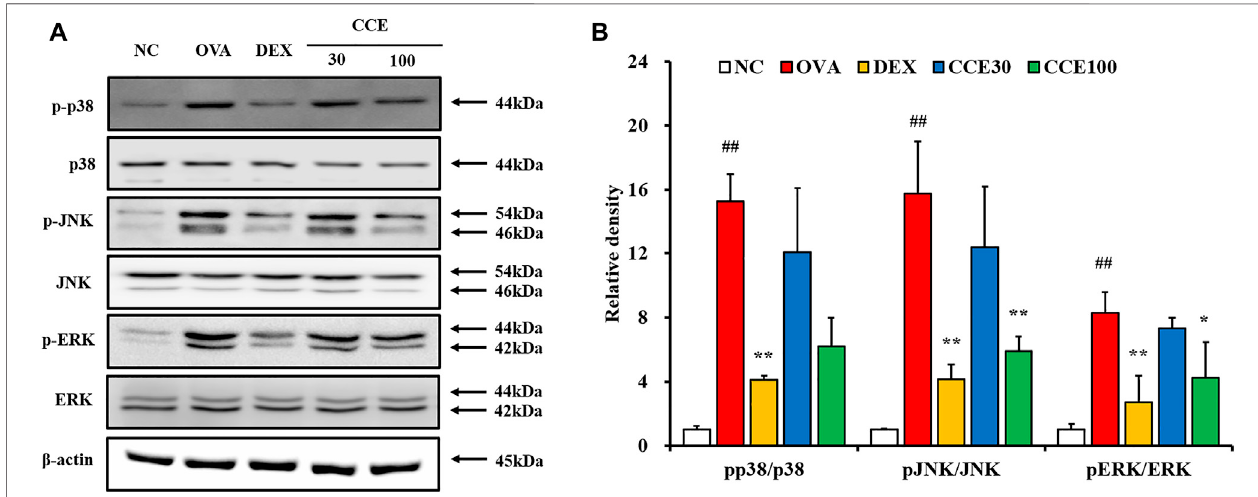
FIGURE 6 | CCE reduced the phosphorylation of MAPKs in OVA-exposed mice. (A) protein expression on the gels, (B) relative density. NC, nonasthma and PBS treatment; OVA, asthma and PBS treatment; DEX, asthma and dexamethasone treatment; CCE 30 and CCE 100, asthma and CCE treatment (30 mg/kg and 100 mg/kg, respectively). ## p < 0.01, vs . NC; *,** p < 0.05 and < 0.01 vs . OVA, respectively ( n = 3 per group).